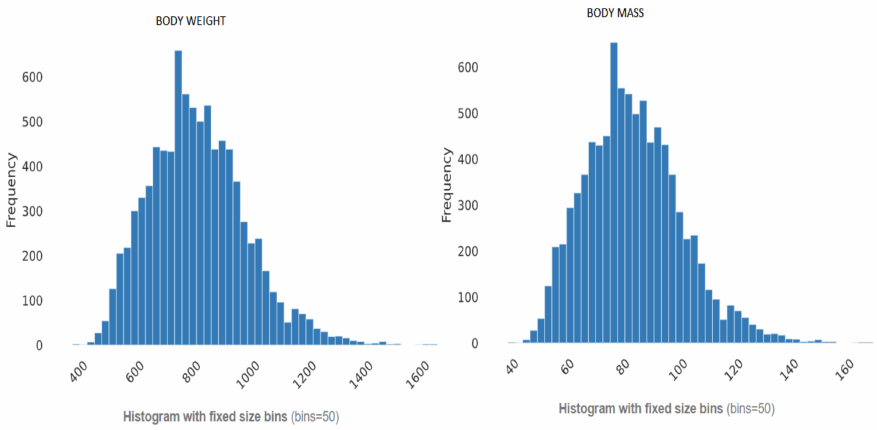
Figure 1. Histograms of BODY WEIGHT and BODY MASS signify high